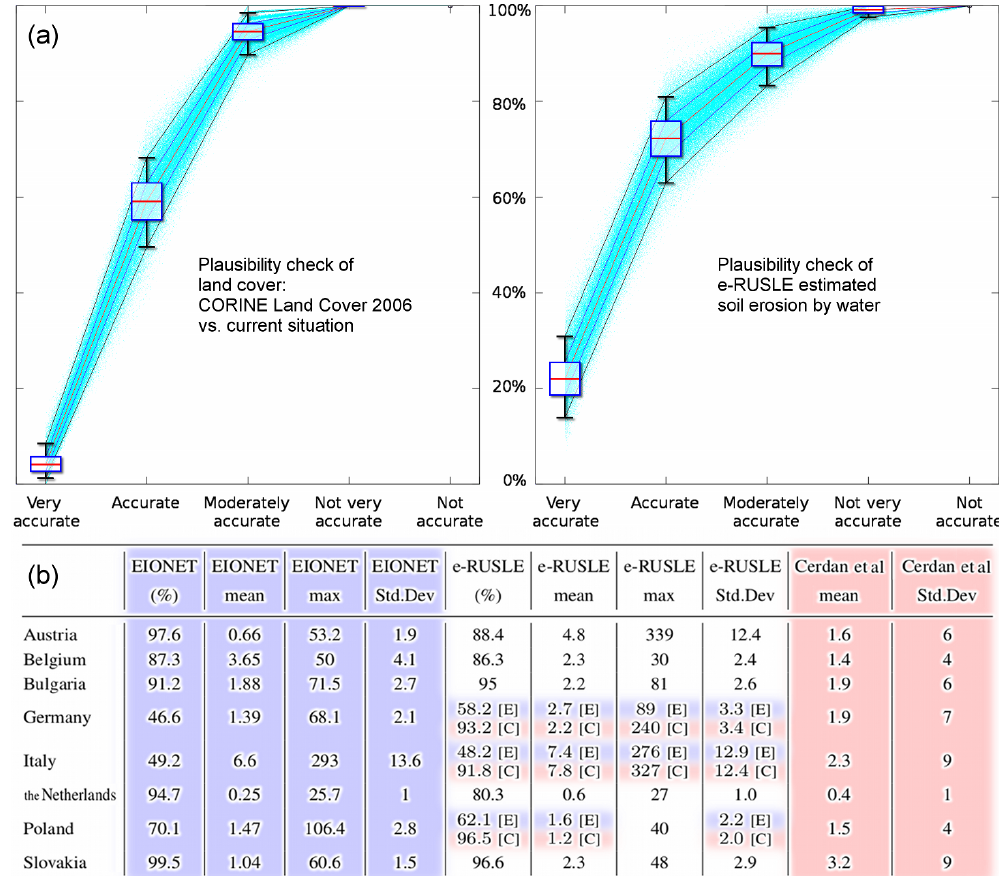
Figure 2. (a) Expert-based plausibility check over 85 random clusters of 3 × 3km 2 grid cells (more than 700 cells and 10000 visual checks were assessed, see Bosco et al., 2014). The bootstrap analysis, based on 10000 runs, shows the bootstrap cumulated distribution of cells with a given level of accuracy (or more accurate). Boxplots: box with quartiles 25%, 50% (red line), 75%; whiskers with 5 and 95% quantiles. (b) e-RUSLE erosion rates (tha − 1 yr − 1 ) per country compared with EIONET [E] and Cerdan et al. (2010) [C] data sets. The percentage (%) of country surface covered by EIONET and Cerdan et al. (2010) is